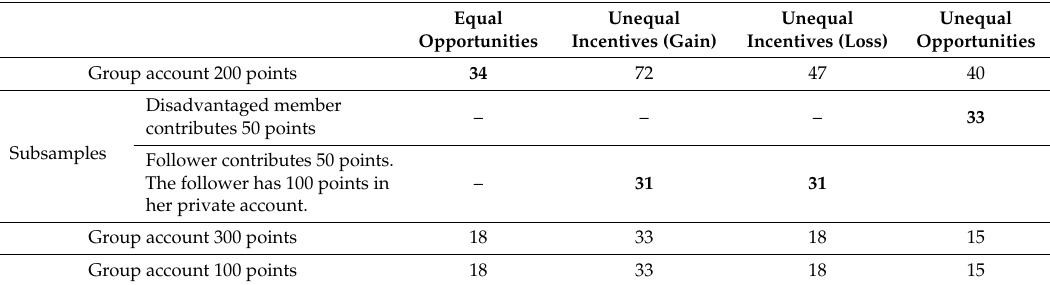
Table 3. Number of (relevant) groups in the different treatments.